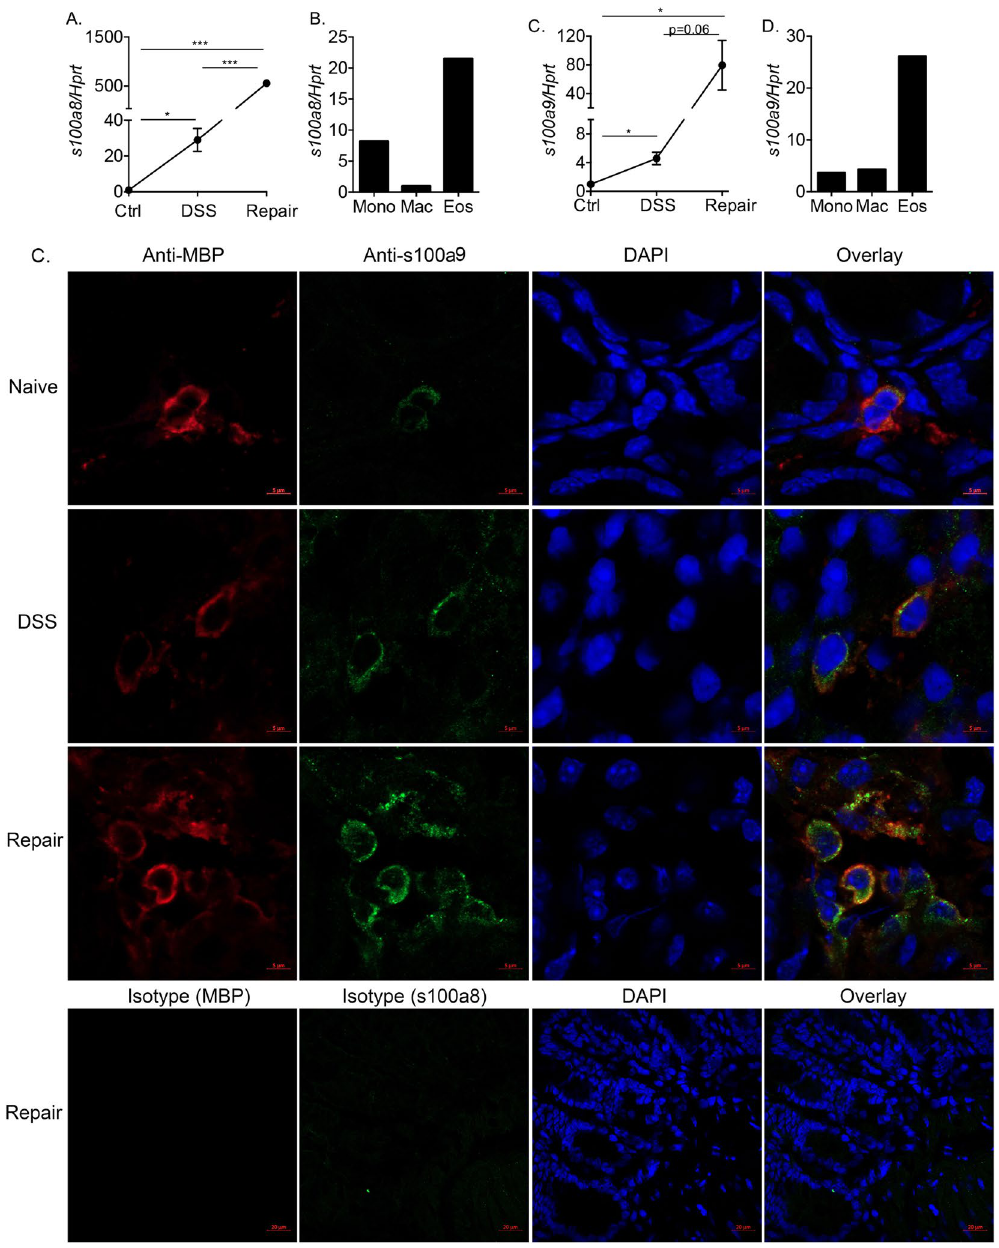
Figure 4. Colonic eosinophils highly upregulate s100a8 and s100a9 during colonic repair. The expression of s100a8 and s100a9 was determined in primary colonic punch biopsies that were obtained from control (Ctrl) mice, and mice during the inflammatory (DSS) and tissue repair stages ( A,C ). The expression of s100a8 and s100a9 in sorted primary colonic eosinophils (Eos), colonic monocytes (Mono) and Macrophages (Mac) was determined by qPCR and normalized to the house keeping gene Hprt . Data in ( A,C ) are from n = 3 *** p < 0.001; * p < 0.05, Data in ( B,D ) are from pooled sorted cell. Frozen sections of mouse colons under various conditions were obtained (including baseline, following DSS-treatment and during colonic repair). Thereafter, the slides were stained with anti-s100a9 (Green), anti-MBP (Red) and DAPI (Blue). High-resolution images of single and double stained MBP + /s100a9 + cells is shown ( D